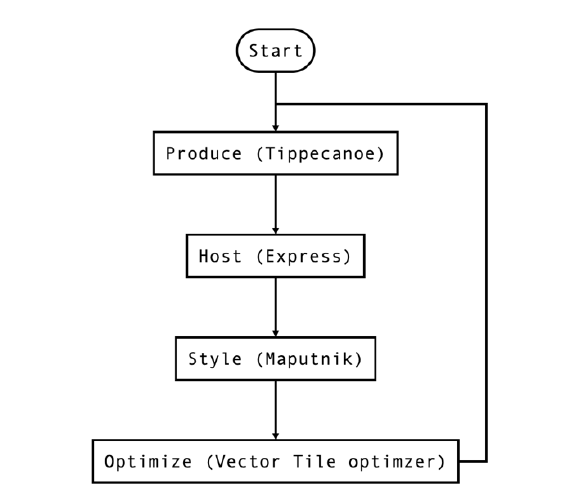
Figure 1. Tasks covered by the UN Vector Tile